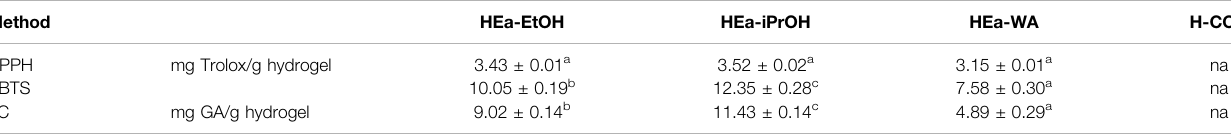
TABLE 3 | The antioxidant activity of hydrogels.